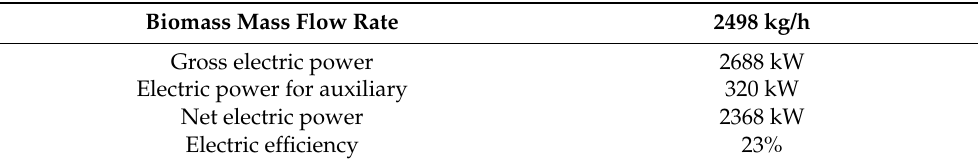
Table 10. Biomass steam power plant (BSPP) characteristics at nominal point operation in the standard configuration